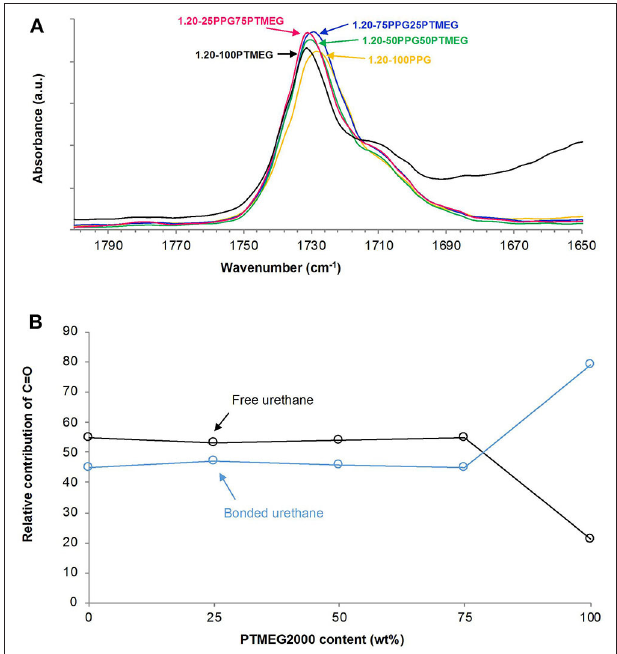
FIGURE 6 | (A) Carbonyl region (1,800–1,650 cm − 1 ) of the ATR-IR spectra and (B) variation of the free and hydrogen-bonded urethane groups as a function of the PTMEG content in the TPUs synthesized with different PPG + PTMEG blends. NCO/OH ratio = 1.20.